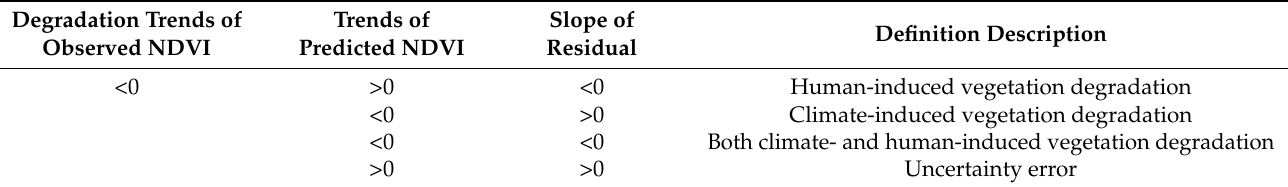
Table 3. Indicators and definitions related to residual analysis